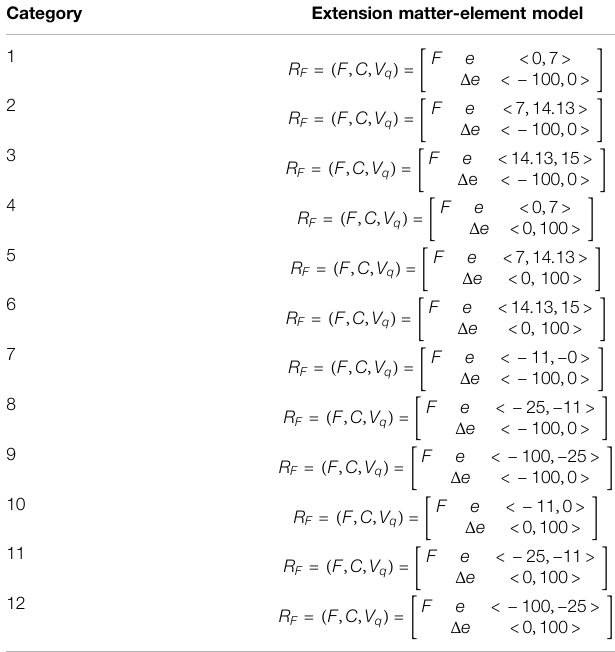
TABLE 1 | Slope error, slope error variation, and duty cycle variation of 12 categories. Category